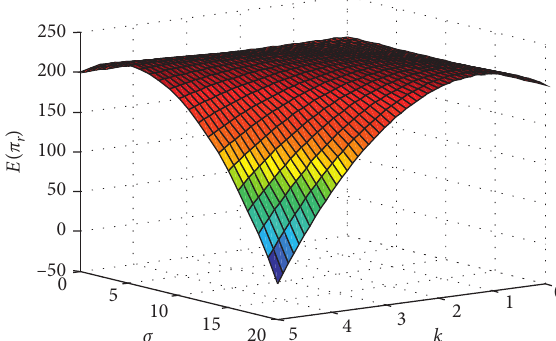
Figure 8: The trend of the retailer’s profits under the Nash equilibrium